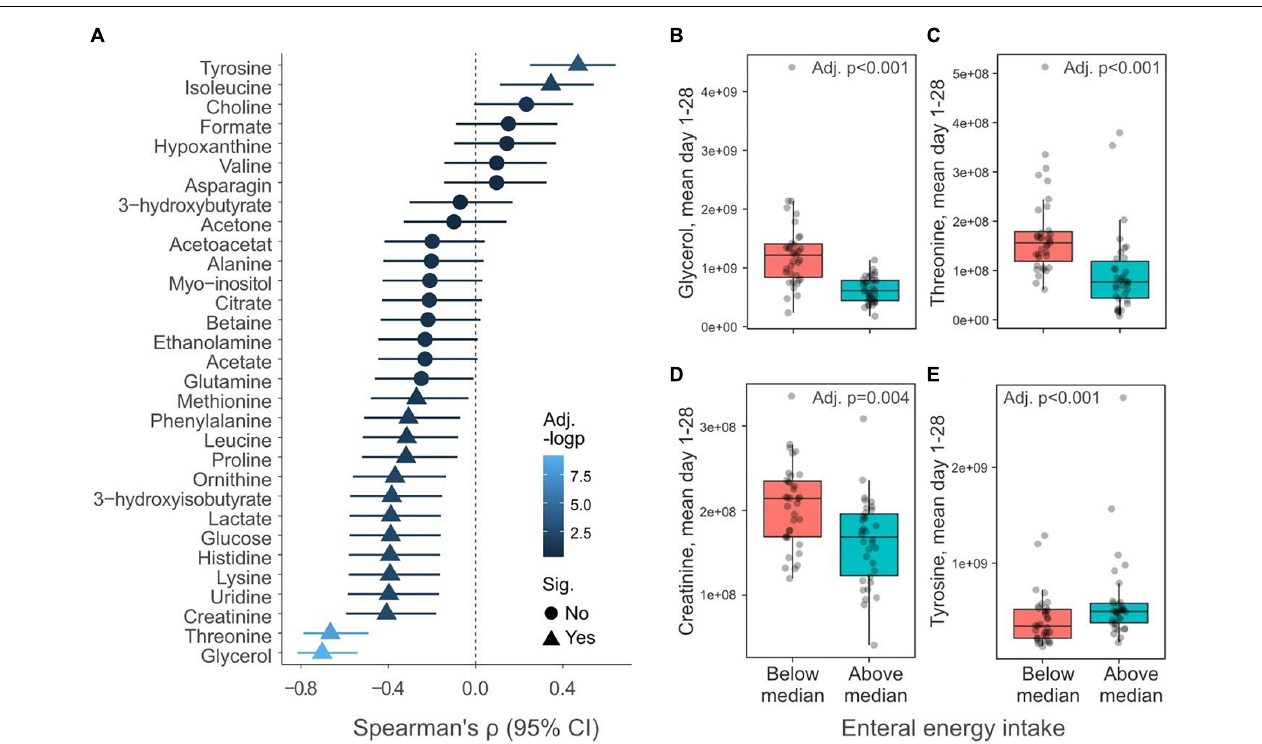
FIGURE 7 | Relationship between enteral nutrition and serum metabolites. (A) Spearman correlation (95% confidence interval) between energy provided as enteral nutrition day 1–28 and mean daily metabolite levels during the corresponding period ( n = 69). Triangles indicate metabolites that significantly ( p < 0.05) correlate with enteral energy intake and the color of the symbols reflect the negative logarithm of the p -value. (B–E) Boxplots show mean daily levels of selected metabolites that depend on the total energy provided as enteral energy. Infants have been dichotomously grouped if they received above ( n = 34) or below ( n = 35) the median amount of total energy as enteral energy day 1–28. Y -axis shows normalized NMR signal. p -values have been false discovery rate adjusted using the Benjamini–Hochberg